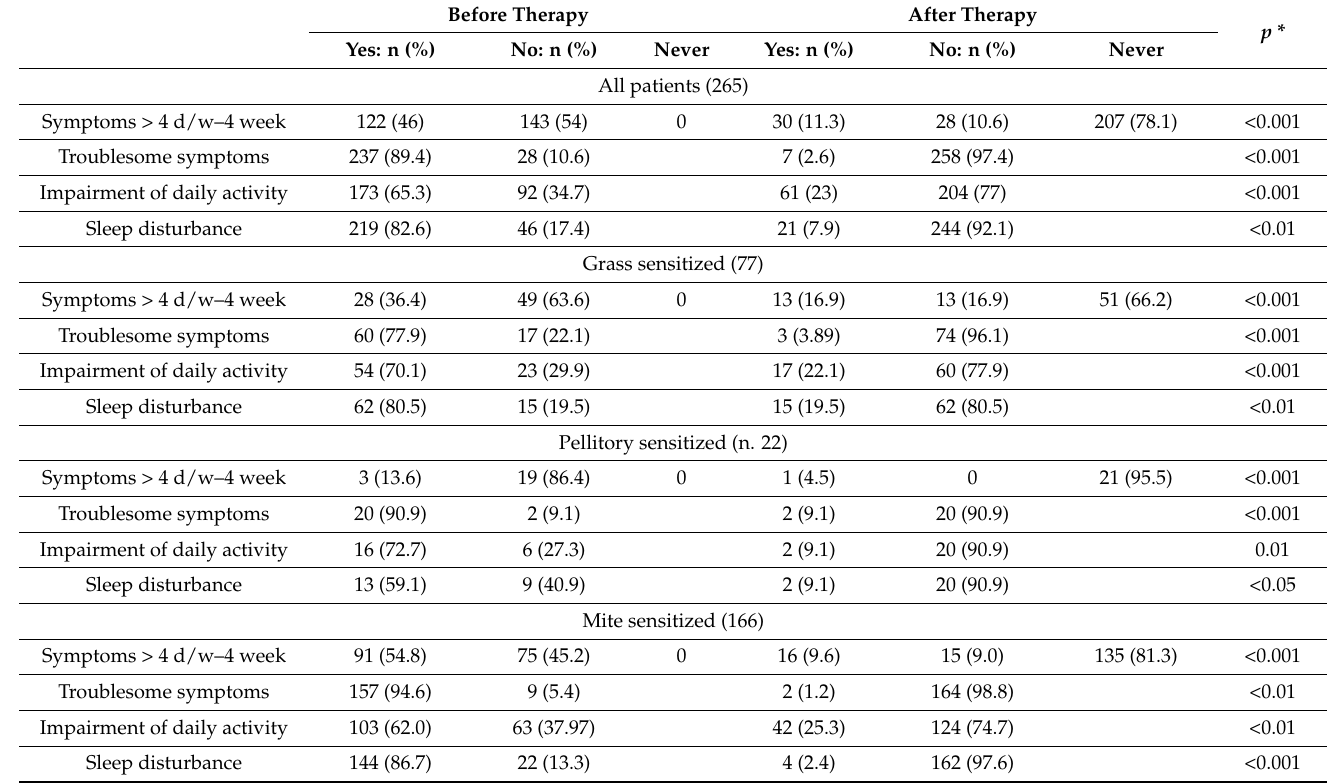
Table 3. Aria classification of rhinitis over the years of AIT (n. 265